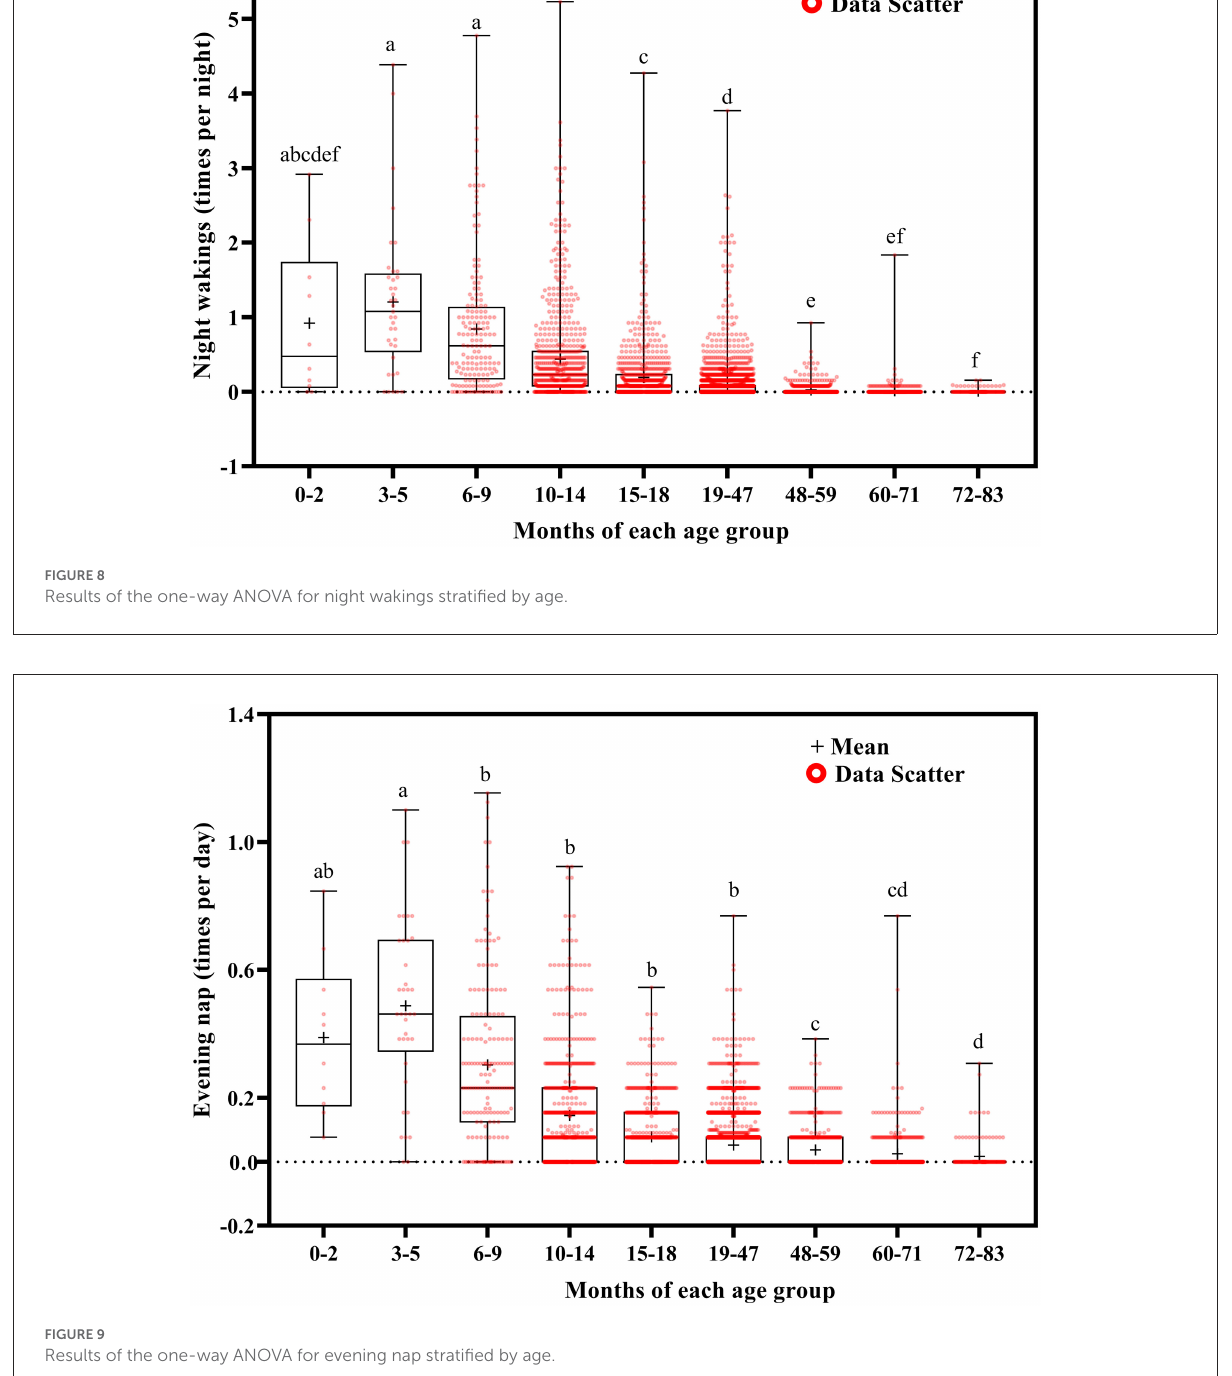
Evening nap frequency tended to decrease with increasing age (Figure 9). Evening naps were more frequent at ages 0–2 months than at ages 48–59 ( p = 0.050), 60–71 ( p = 0.040), and